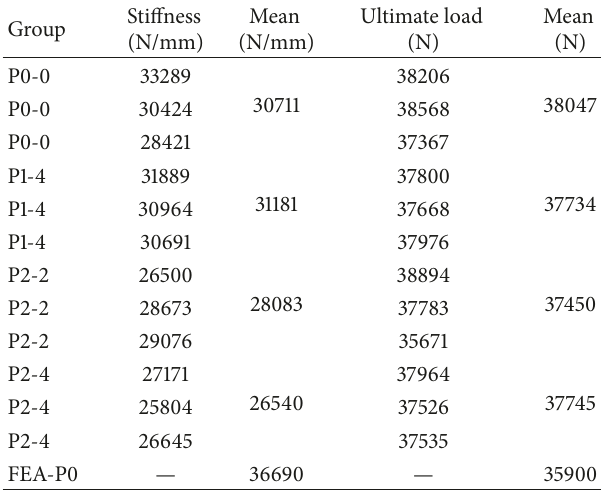
Table 5: The experimental and numerical bearing behaviors of all